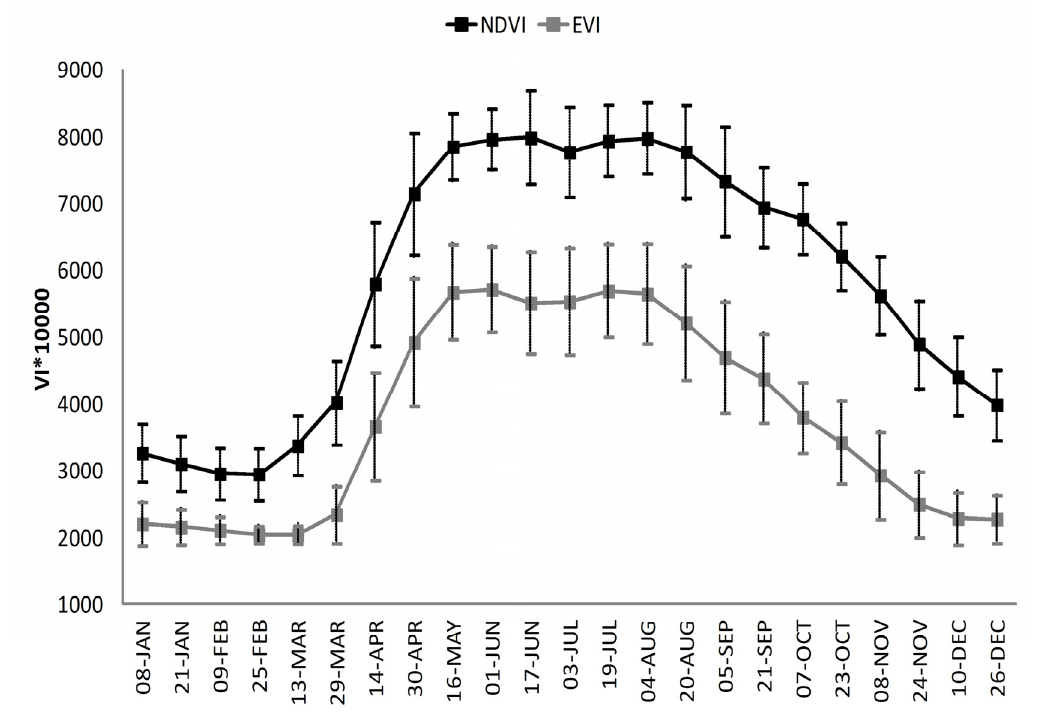
Figure 6. Temporal profile of NDVI and EVI (bars represent standard deviation) in all sampled hay meadows (286 sites).